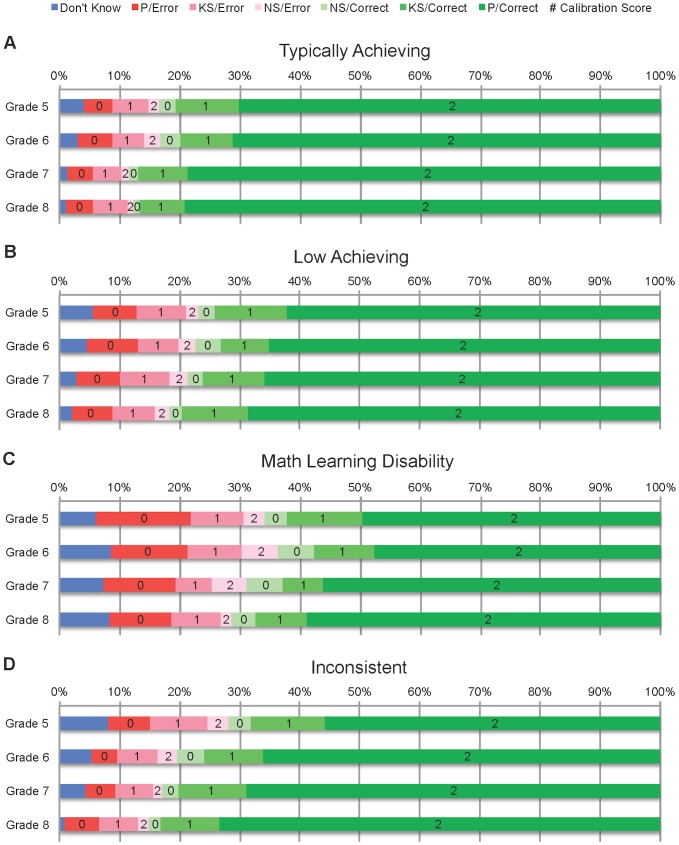
Mean proportion of PVT responses by correctness/confidence, mathematics achievement status, and grade, with calibration scores.For correct (green) and incorrect (red) responses, darker shades represent higher levels of confidence.